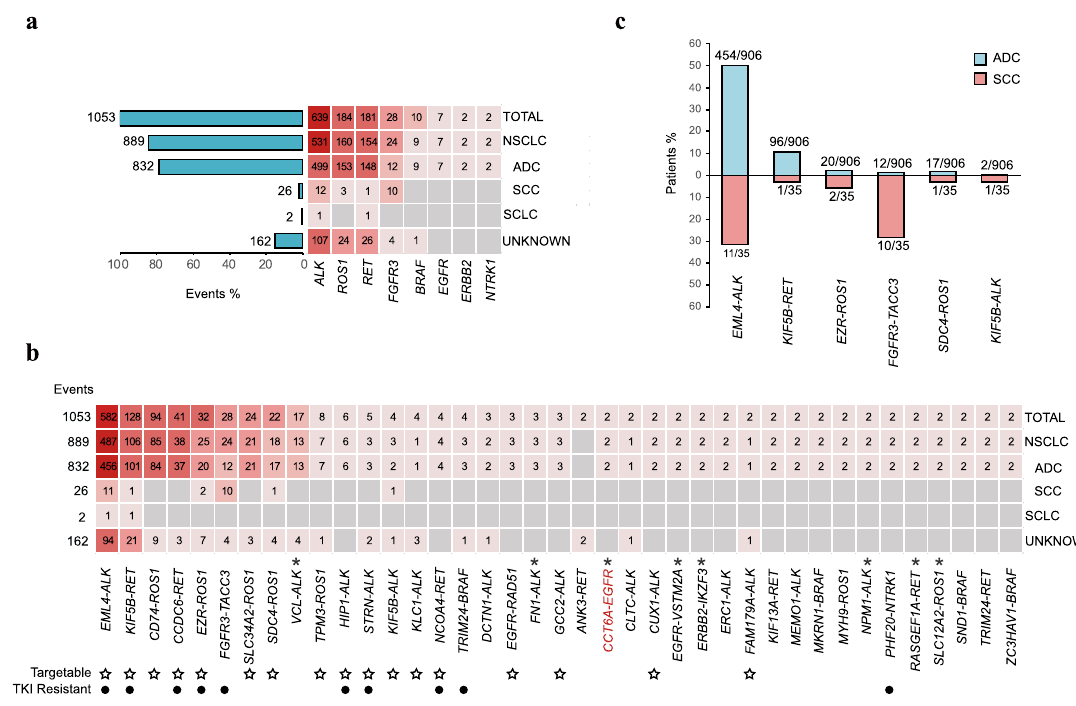
Fig. 2 Recurrent kinase fusions in lung cancer. a Kinases involved in fusions in different lung cancer subtypes and the number of events in each lung cancer subtype is shown to the left of each bar. b Kinase fusions in different lung cancer subtypes and the number of events in each lung cancer subtype is shown on the left. The fusion in red is a novel kinase fusion that has not been previously reported in all cancer types. Fusions marked with * represent kinase fusions never reported in lung cancer. The ☆ showed the targetable kinase fusion and the (cid:129) represent the fusion which was identi fi ed as resistance mechanism to EGFR TKI or fusion TKI. c Comparison of the prevalence of kinase fusions in ADC and SCC. The number of patients with each fusion and the total number of patients in ADC or SCC are shown on the top of each